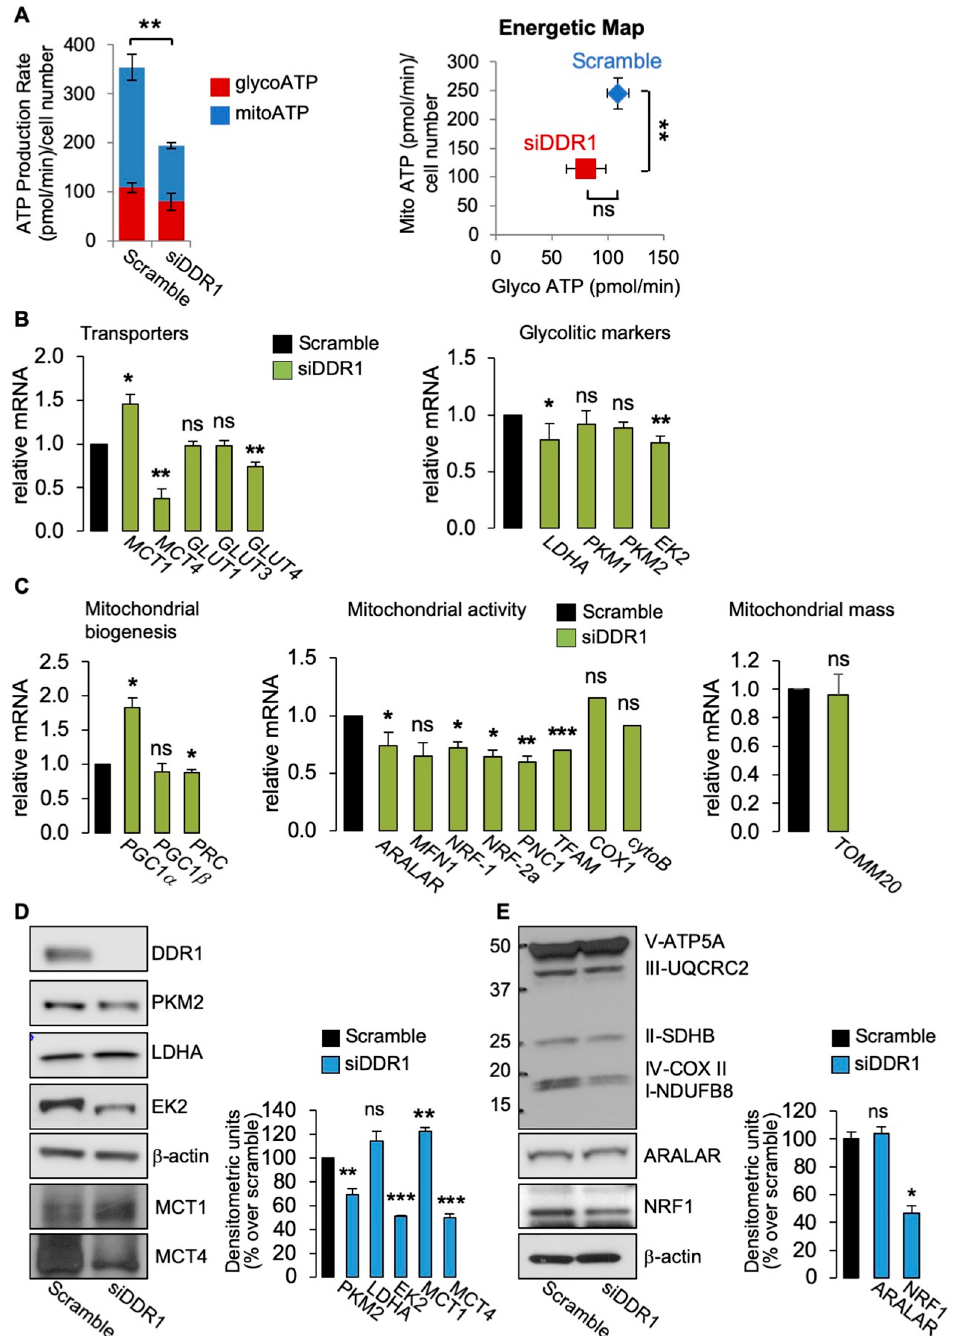
used as housekeeping control gene. Data are presented as the means ± SEM of three independent experiments. the indicated primary antibodies. In particular, to assess receptor autophosphorylation, we used anti-phospho-(p)IGF1R (Tyr1135/1136)/pIR (Tyr1150/1151) antibody detecting both pIR and pIGF1R and anti-pIR (Tyr1334) antibody, specific for pIR. β -actin was used as control for protein loading. Blots are representative of three independent experiments. Side panels show densitometric analysis. (ns, not significant; *, p < 0.05; **, p < 0.01; ***, p < 0.001; Student’s t -test).